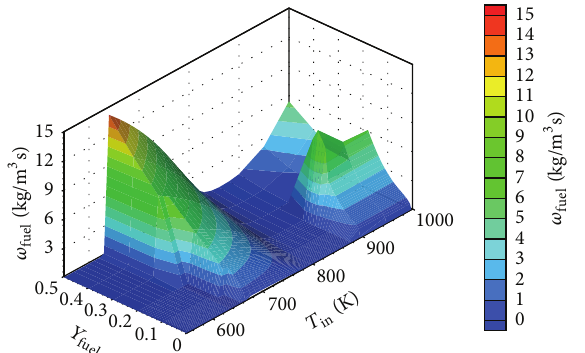
Figure 5: Predictions of fuel consumption rate per unit volume as a function of inlet temperature and fuel concentration ( 𝑡